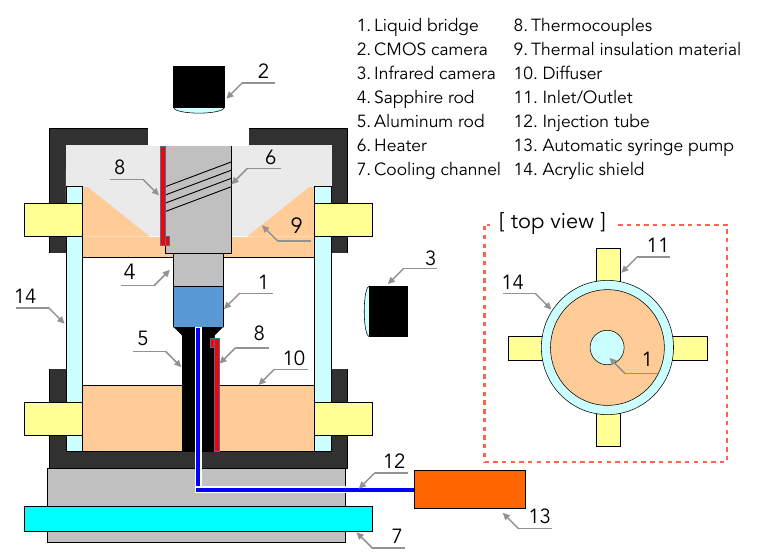
Figure 2. Cross-sectional view of the experimental apparatus (not to scale). The liquid bridge is heated from above in this configuration. A narrow ZnSe window is placed at a portion of the external shield for the infrared camera to detect the surface temperature through the shield. The CMOS camera for the side view and the displacement sensor are omitted. (Figure 3 in Gotoda et al.